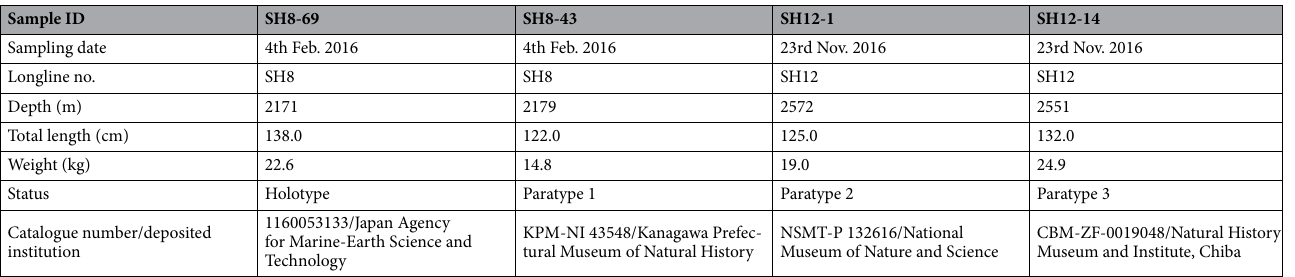
Table 1. Sampling dates and depths for the captured Narcetes shonanmaruae specimens. Depth information was derived from the data logger records closest to each hooked